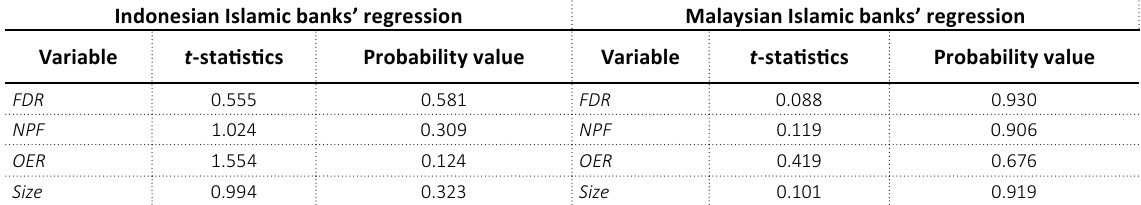
Table 9. Glejser test results